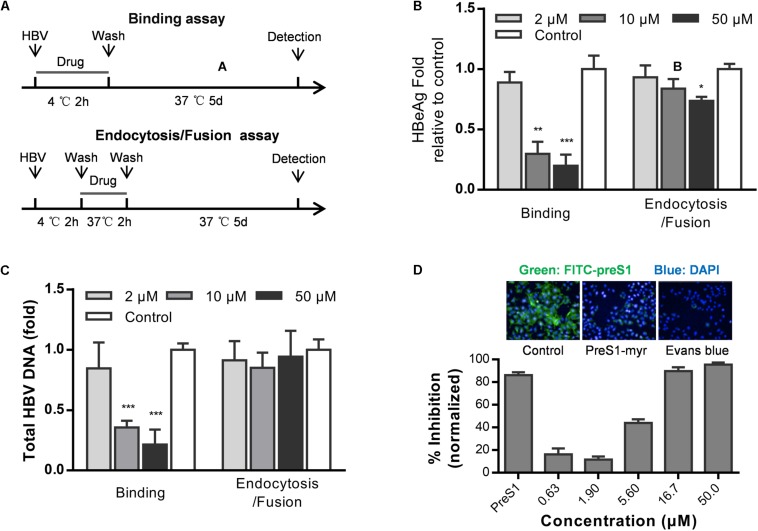
Evans blue inhibits the binding of HBV preS1 to host cells. (A) Experimental setup, binding assay (upper) and endocytosis assay (lower). (B,C) Huh7DhNTCP cells were incubated with HBVs at 4°C for 2 h to enable binding but without endocytosis. Then the unbound HBVs were washed out, and cells were cultured at 37°C for 2 h to allow HBV entry. The cells were cultured for 16 h to allow HBV infection. At dpi 5, supernatant HBeAg levels and HBV total DNA levels were measured. (D) Cells were pretreated with or without Evans blue, the FITC-preS1 binding was detected using a PerkinElmer Operetta. preS1 at 0.1 μM was used as a positive control. The total fluorescence intensity was determined for each concentration. Statistical significance was determined using Two tails Student’s t-test (∗P < 0.05, ∗∗P < 0.01, ∗∗∗P < 0.001).